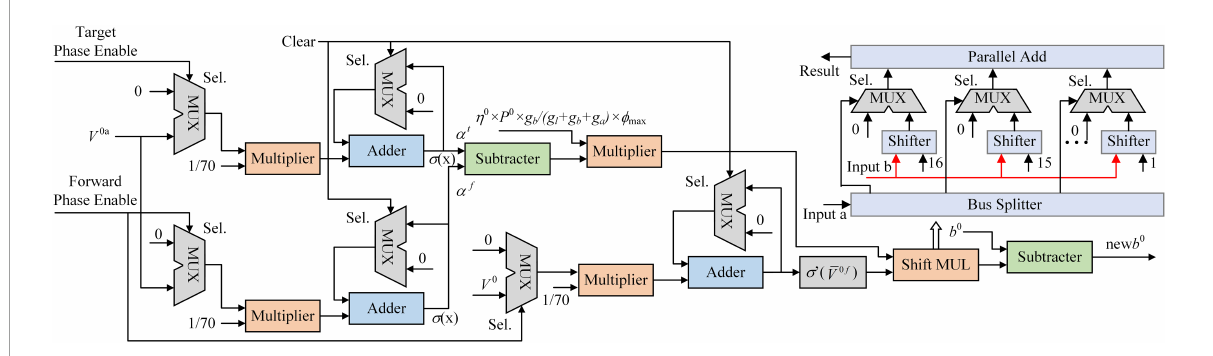
FIGURE6 The architecture of synaptic plasticity. The synaptic plasticity module is implemented on the field-programmable gate array (FPGA) as an on-chip learning system. A shift multiplier (MUL) module is proposed to replace DSP blocks on the FPGA to reduce logical resource